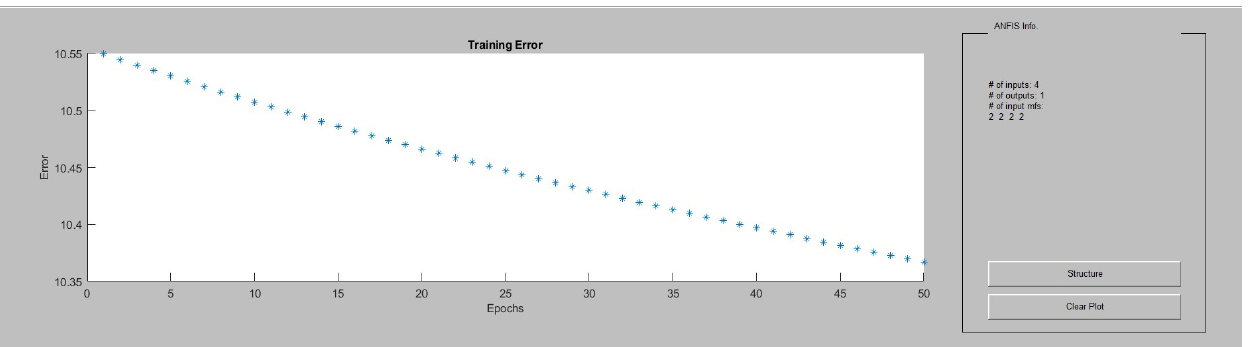
Figure 13. Training